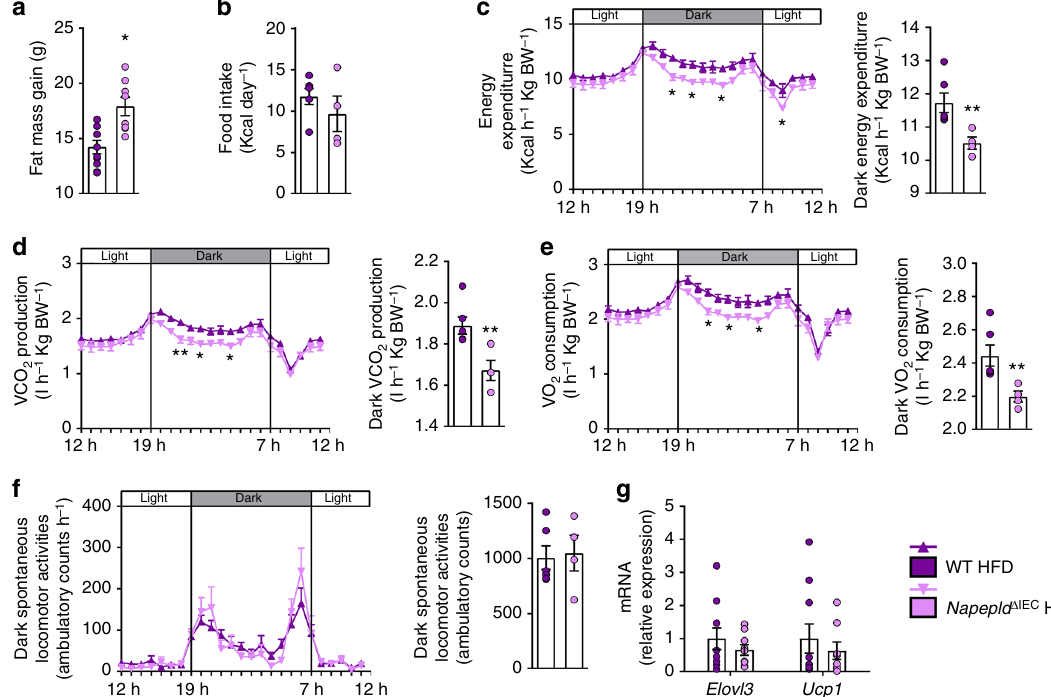
Fig. 5 Phenotype of Napepld Δ IEC mice after 16weeks is associated with lower energy expenditure. a Fat mass gain (g) after a 16 weeks period. b Daily HFD intake (Kcal/day) measured in metabolic chambers during indirect calorimetry studies at the 16th week of HFD feeding. c Light and dark cycle energy expenditure (Kcal h − 1 Kg body weight − 1 ) measured in metabolic chambers. d Light and dark cycle of CO 2 production (l h − 1 Kg body weight − 1 ). e Light and dark cycle of O 2 consumption (l h − 1 kg body weight − 1 ). f Light and dark cycle spontaneous locomotor activities (Ambulatory Counts h − 1 ). g mRNA expression of Elovl3 and Ucp1 in the subcutaneous adipose tissue. For a – f , n = 8 – 10. For g , n = 8 – 10. Purple: WT HFD mice and pink: Napepld Δ IEC HFD mice. Data are presented as the mean ± s.e.m. Asterisks (* and **) indicate a signi fi cant difference versus WT HFD (Respectively P < 0.05 and P < 0.01) according to Mann – Whitney test or repeated measures two-way ANOVA followed by Bonferroni ’ s post-hoc